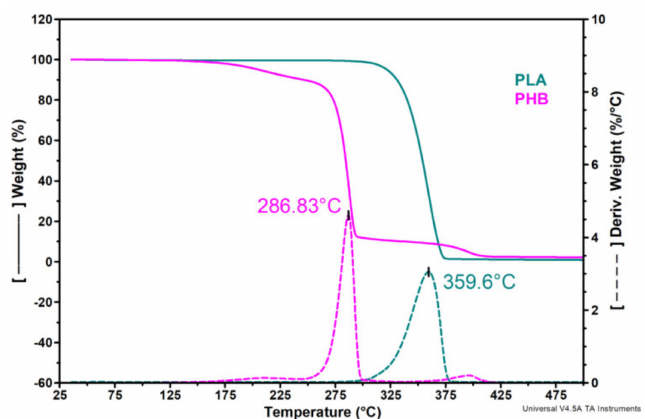
Figure 8. Thermogravimetric curves (TG) and their derivatives (DTG) for PLA and PHB.